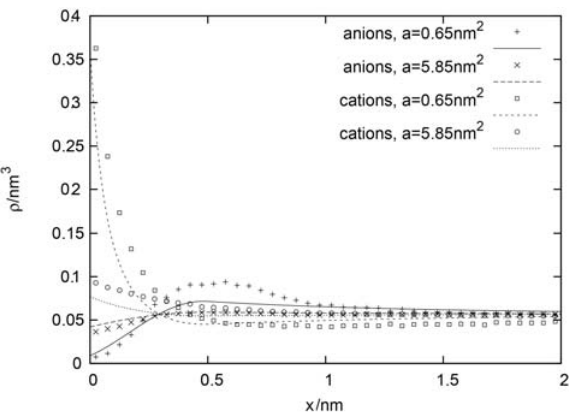
Figure 2. Density profiles of small mobile ions next to the zwitterio- nic layer at Debye length equal to 1nm. Corresponding monovalent salt concentration is 0.092 mol/L. Symbols represent Monte Carlo data and lines theory. Legend: + and full line : negative ions at a = 0.65 nm 2 ( σ = –0.2465 C/m 2 ); × and - - - : negative ions at a = 5.85 nm 2 ( σ = –0.0274 C/m 2 ) (cid:2) and …… : positive ions at a=0.65 nm 2 ; (cid:3) and - - - : positive ions at a = 5.85 nm 2 .